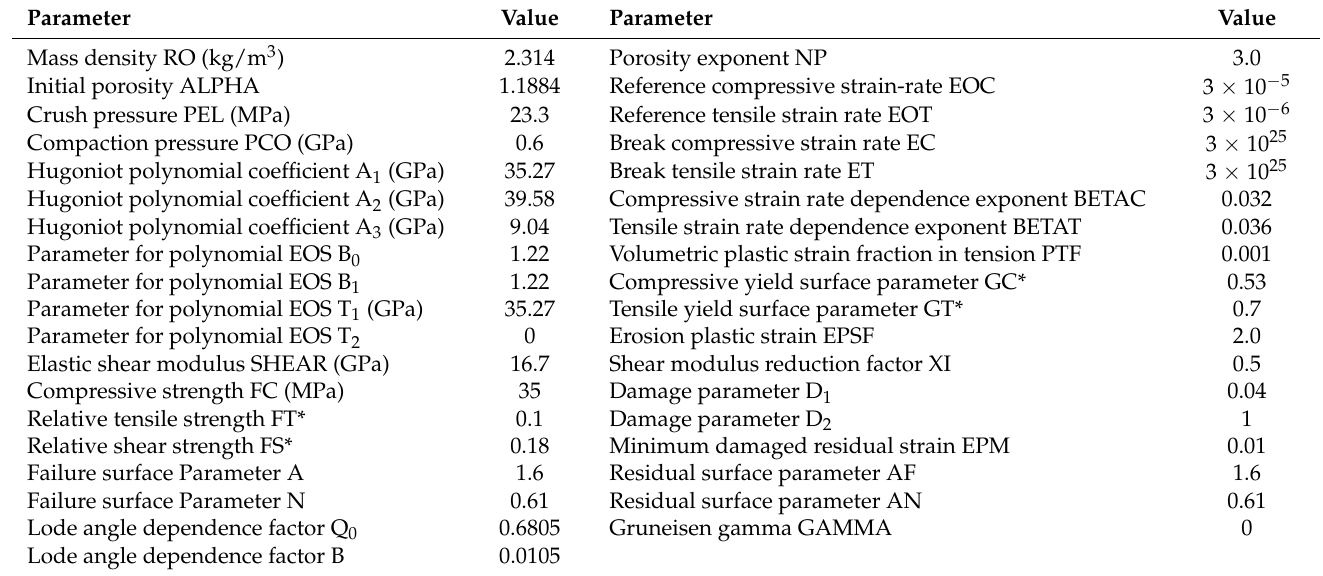
Table 1. Input parameters for RHT model for rock